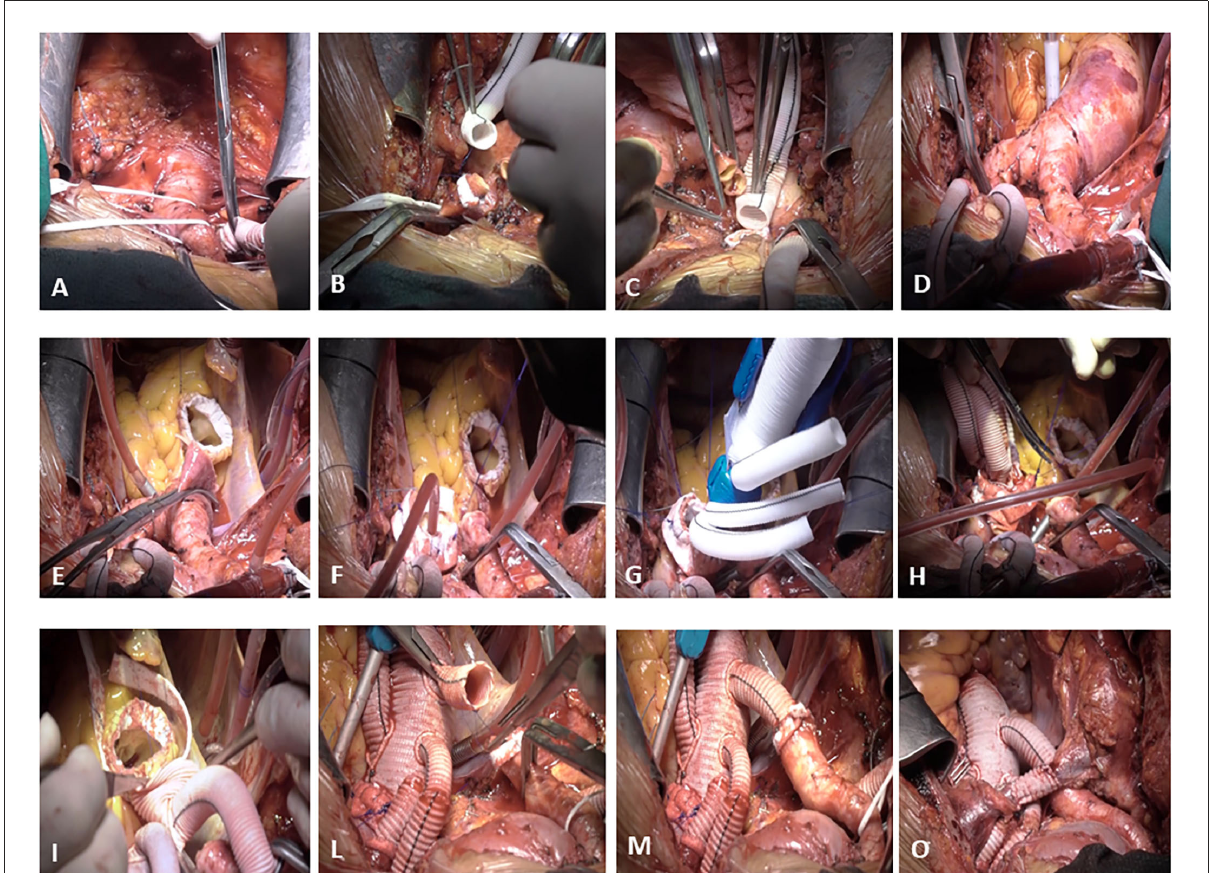
FIGURE1 De-branching first surgical technique. The right subclavian artery is isolated from the anterior mediastinum and an end-to-side Dacron vascular graft (8 or 10mm, depending on the native vessel size) is interposed to avoid direct cannulation of the artery (A) . During the first cooling phase, from a beating heart, the left common carotid artery (LCCA) (B) and the left subclavian artery (LSA) (C) are isolated and prepared for selective cannulation with the interposition of a vascular Dacron graft. After the completion of debranching (D) , the ascending aorta is cross-clamped and opened, cardioplegia is administered, and the proximal aortic valve and root reconstruction are performed in different manners as required by the case (E) . The brachiocephalic artery is clamped, the aortic arch is then opened and inspected, and the landing zone (usually zone 2) is reinforced with internal and external teflon strips (F) . At this stage, the distal stent graft of the Thoraflex hybrid is released into the DTA (G) . The strengthened collar of the prosthesis is sutured to the aorta (H) , and, after cannulation of the fourth lateral branch and accurate de-airing, a systemic perfusion is resumed. The anastomosis between the hybrid prosthesis and sino-tubular junction (either native or prosthetic, depending on the proximal repair) is then completed (I) and the cross-clamp is released. The prosthesis-elongated supra-aortic vessels are then termino-terminally re-anastomosed to the corresponding branches of the Thoraflex hybrid (L) , starting with the LSA to LCCA and finally to the brachiocephalic artery (M) . Finally, the anonymous vein is reconstructed with the interposition of an 8mm Dacron vascular graft (O)